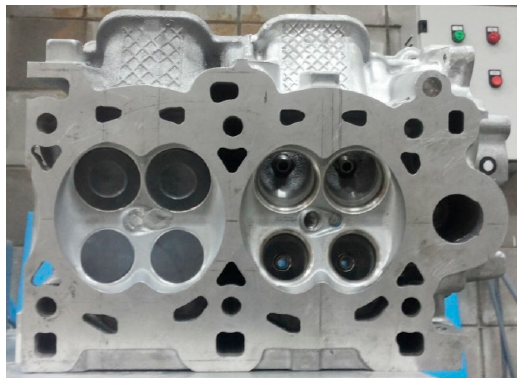
Figure 2. Gasoline Direct Injection (GDI) cylinder head.